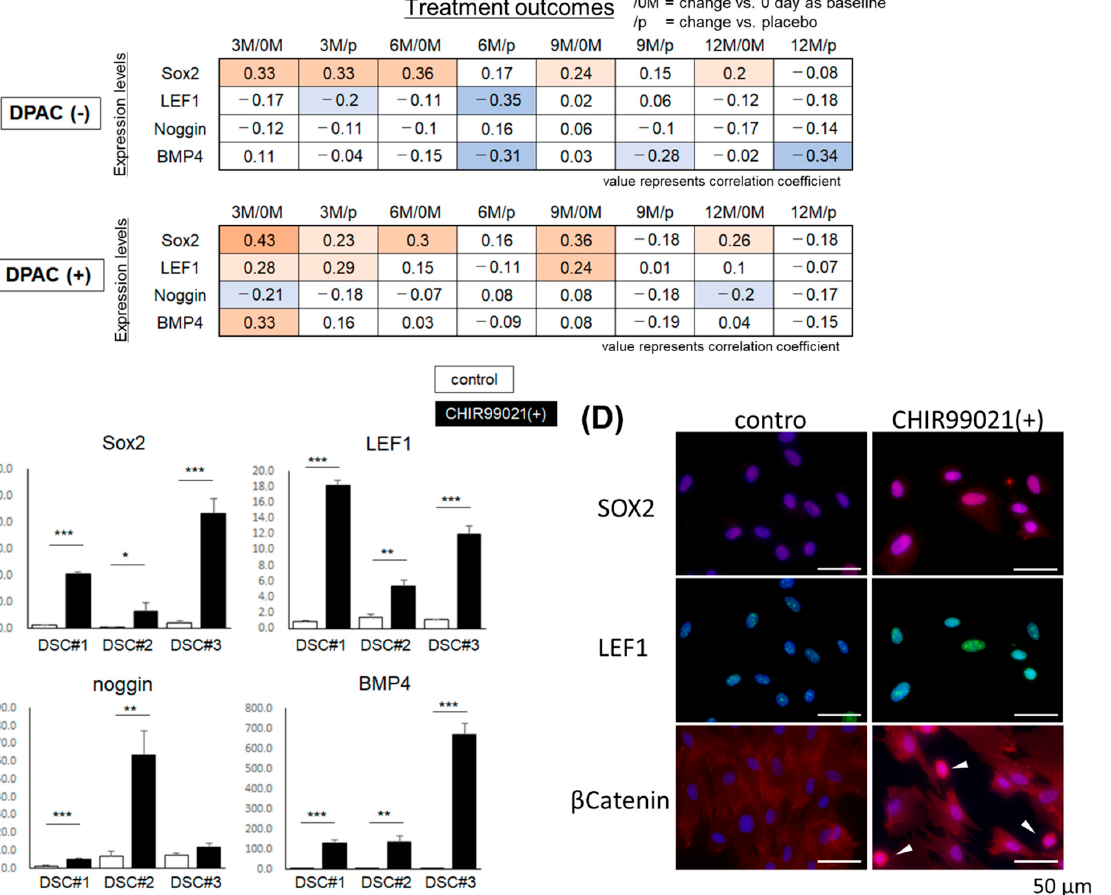
Figure 3. Effect of DPAC medium and CHIR99021 treatment on DSC cells. ( A , B ) Correlation between the treatment outcome score at 3, 6, 9, and 12 months vs. day 0 (3 M/0 M, 6 M/0 M, 9 M/0 M, and 12 M/0 M) or vs. placebo (3 M/p, 6 M/p, 9 M/p, and 12 M/p) during the clinical study using DSC cell lines [21], and the expression levels of DP markers. Each value represents the correlation coefficient. Red: positive correlation; blue: inverse correlation. ( C ) Relative expression levels of Sox2, LEF1, Noggin, and BMP4 in three DSC cell lines (DSC#1–#3) cultured in medium (control) or with 3 µ M CHIR99021 ( n = 3). Expression levels were normalized to GAPDH and the results are expressed as the mean ± S.D. Student’s t -test, * p < 0.05, ** p < 0.01, *** p < 0.001. ( D ) Immunostaining of DSC cells cultured in control or CHIR99021-containing medium for SOX2 (red), LEF1 (green), and β -catenin (red). Blue indicates Hoechst 33,342 nuclear staining. Arrowheads: β -catenin nuclear translocation. Bars = 50 µ